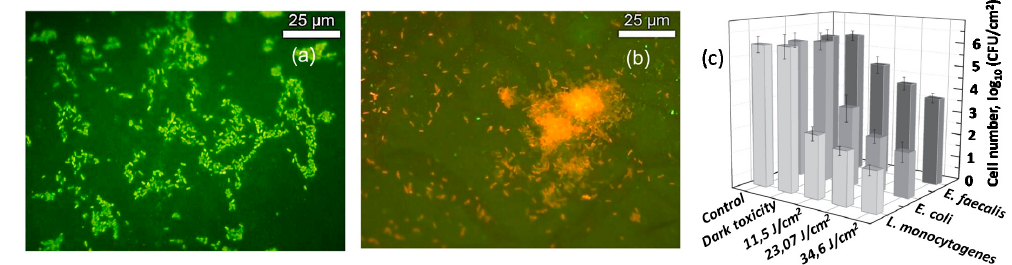
Figure 8. Fluorescence micrographs of E. coli biofilms grown up onto ZnO NRs surfaces: ( a ) without; or ( b ) with light treatment. Alive cells were stained in green and dead cells in red; ( c ) Light-dose dependence cytotoxic effect on E. faecalis MSCL 302, L. monocytogenes ATCL3C 7644 and E. coli